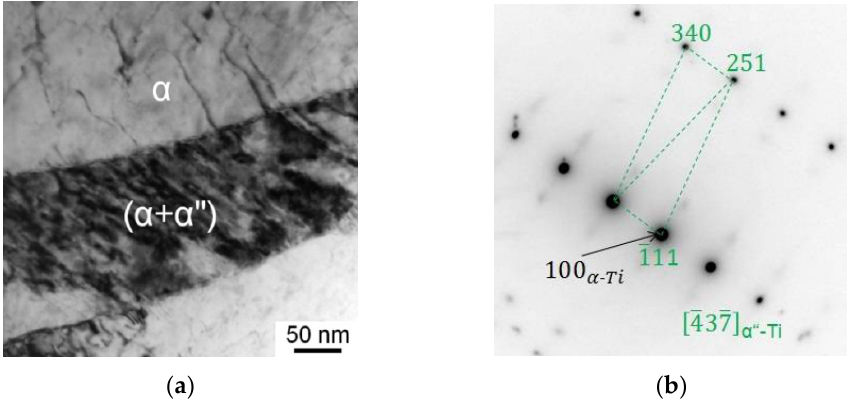
Figure 8. TEM bright-field image ( a ) and an associated SAED pattern ( b ) illustrating the micro- structure of the Ti-6Al-4V samples subjected to UIT. The micrographs were obtained at a depth of 45 µm below the treated surface.